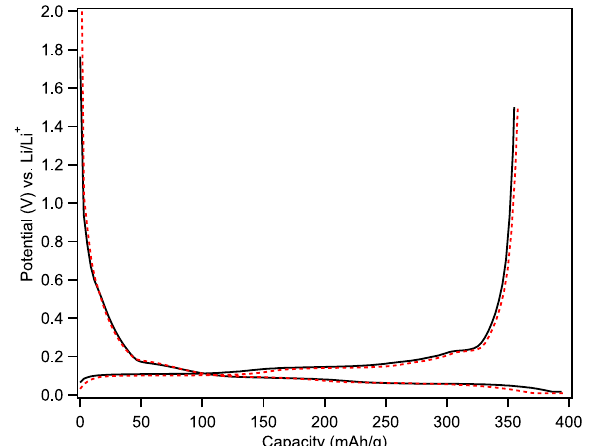
Figure 8. First cycle galvanic charge and discharge curves of sBCG (solid black lines) and MagE3 (dashed red line).